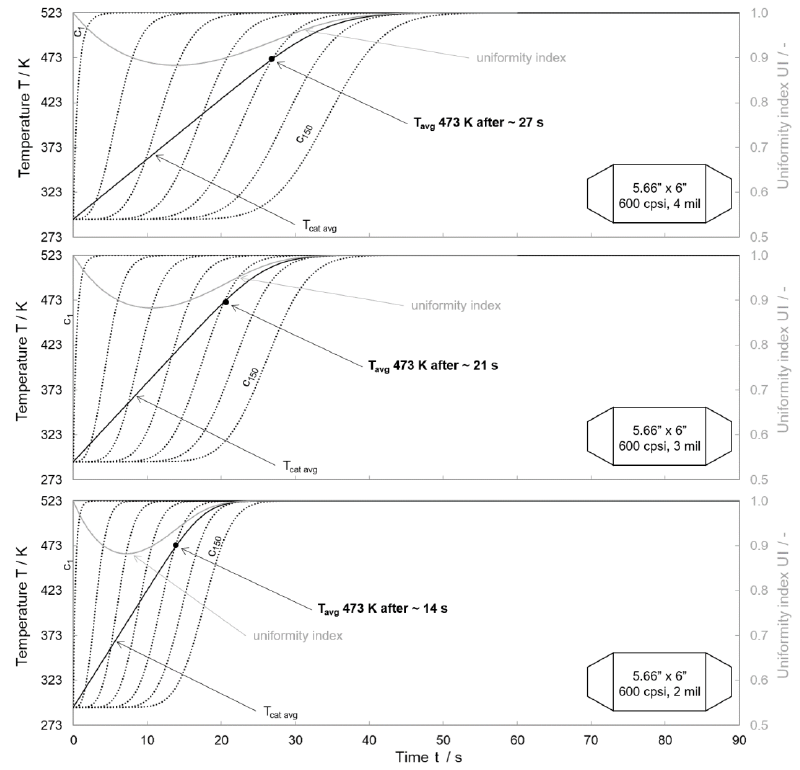
Figure 14. Steady state heat-up of 600 cpsi monoliths at a flow rate of 100 kg/h and 523 K. The last variation in this comparison focuses on alterations in cell densities by simul- taneously keeping the wall thickness constant, as primarily presented in Figure 15. This comparison can be extended to the 600 cpsi monolith with 2 mil given in Figure 14 since the wall thickness is equal. We notice that the heat-up phase is prolonged by increasing cell densities. Within the 2 mil monoliths, the 600 cpsi substrate exhibits the fastest heat- up, although the internal surface area and the heat transfer coefficient are smaller than with higher cell densities. This behavior requires a more detailed analysis and is discussed in the subsequent paragraphs.